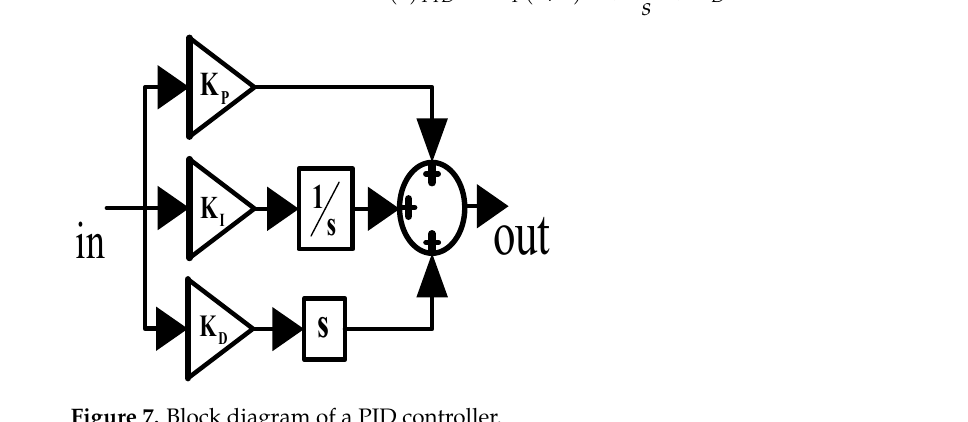
Figure 7. Block diagram of a PID controller.